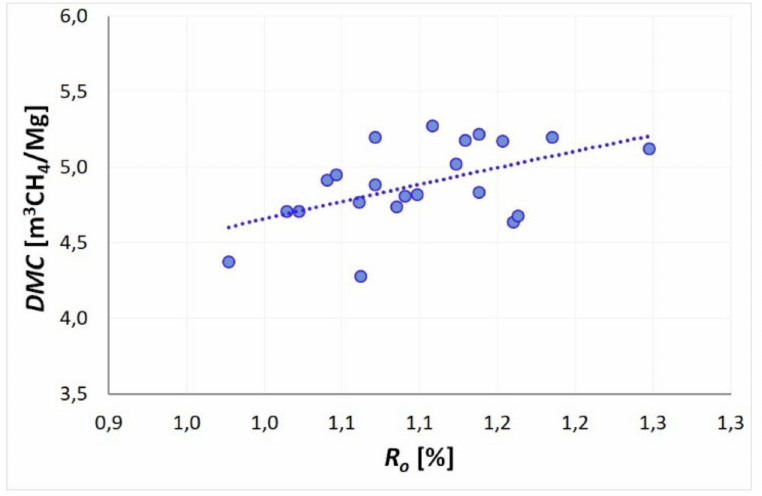
Figure 9. Desorbable methane content as a function of coalification degree ( Mn = 8 m 3 CH 4 /Mg, 35 ◦ C).